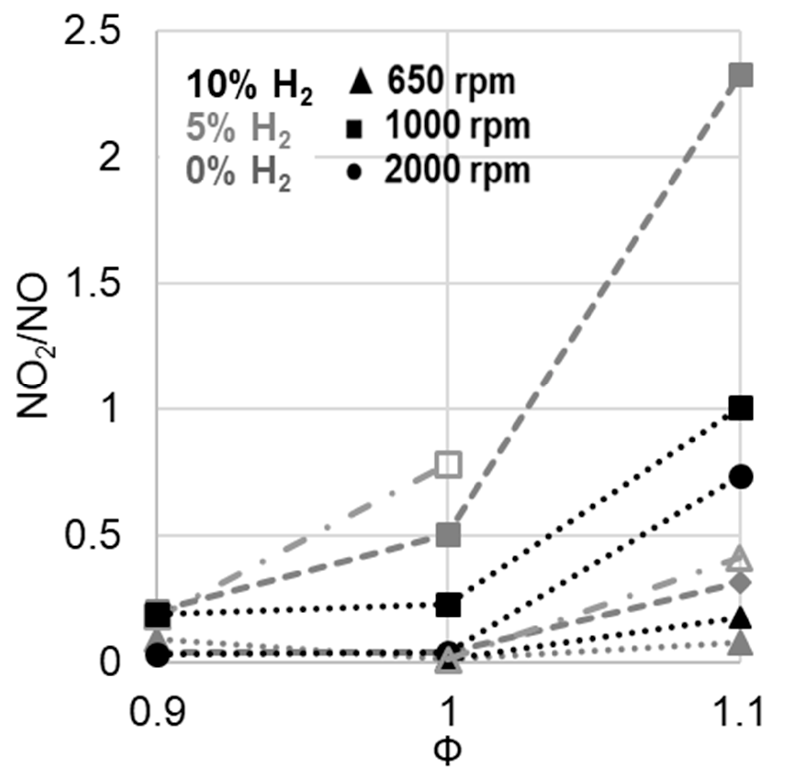
Figure 5. NO 2 /NO emissions vs equivalence ratio for different engine speeds and H 2 content, P in = 1 bar.